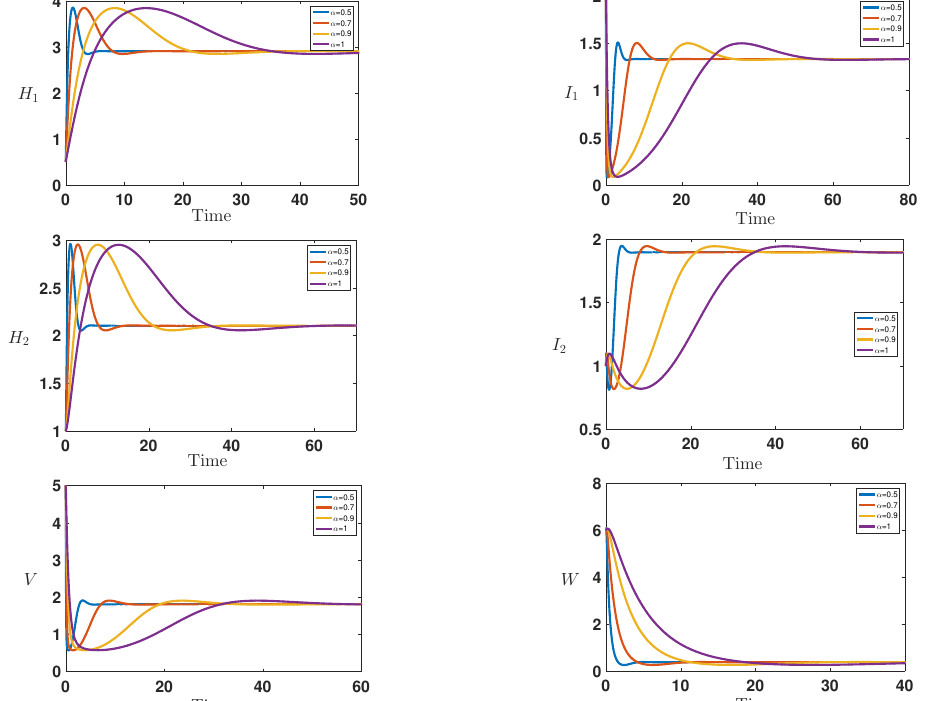
Figure 3. Behavior of the infection during the time for s 1 = 1, s 2 = 0.8, b 1 = 0.08, b 2 = 0.1, d 1 = 0.2, d 2 = 0.2, a 1 = 0.2, a 2 = 0.2, k 1 = 1, k 2 = 1.2, p = 0.3, r = 0.2, σ = 2 and q = 0.16, which correspond to the stability of the endemic equilibrium E 2 = ( 2.9069,1.3333,2.1052,1.8947, 1.800,0.2221 ) ( R 0 = 2.2 > 1 and R 1 = 1.25 >